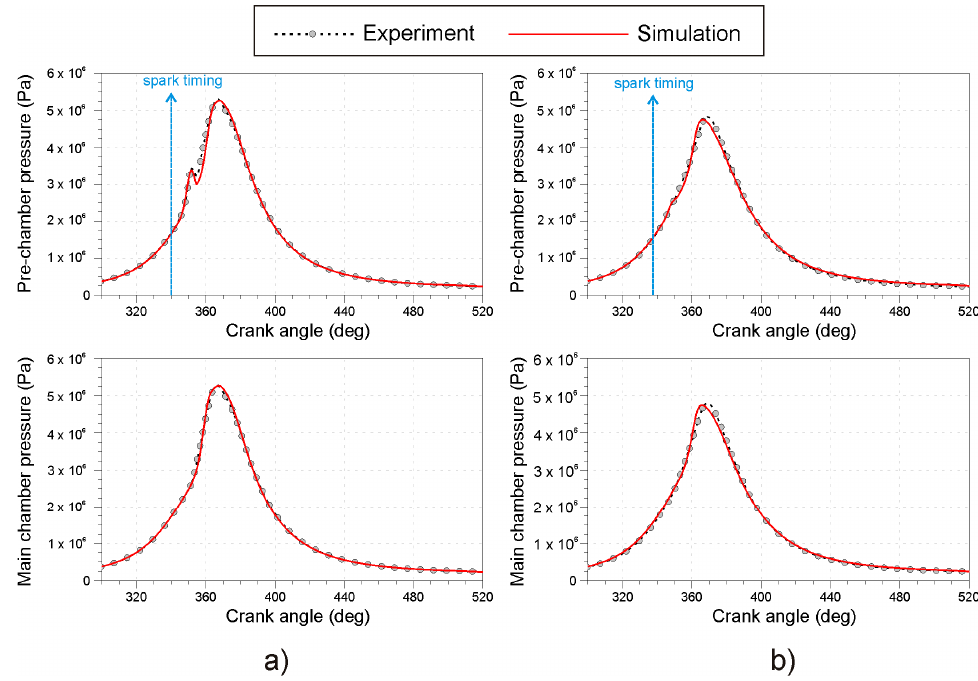
Figure 11. Calibration of combustion model—comparisons of pre-chamber and main chamber pressure traces for pre-chamber design (IN) with: six orifices ( a ); and four orifices ( b ) at an exhaust air excess ratio of 1.8.